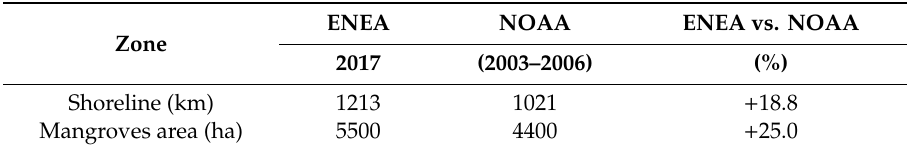
Table 2. Length of shoreline (km) and mangrove areas (ha) on Palau Archipelago computed in the present work (ENEA) and by NOAA (Analytical Laboratories of Hawaii, 2007). Di ff erences are in percentages (%).